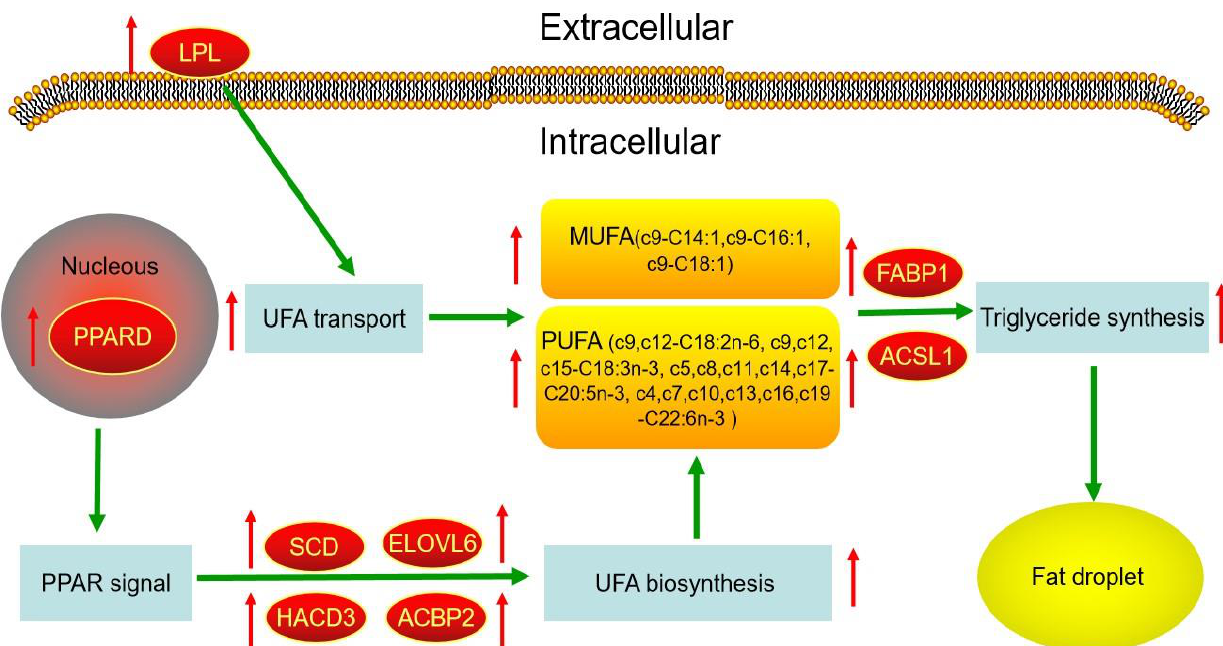
Figure 5. The potential regulatory network of UFAs metabolism according to the DEPs. Green arrows indicate the possible regulatory relationships. Box represents the metabolic process and UFAs. Red oval represents the crucial protein in UFAs metabolism. Red arrow represents the upregulated expression, and green arrow represents relevance or consequence.